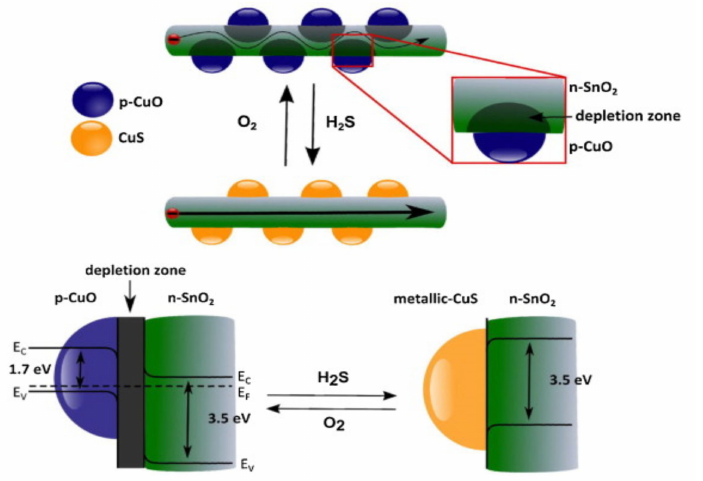
Figure 9. Sensing mechanism of CuO-SnO 2 heterojunctions. Reprinted from [85] with permission from